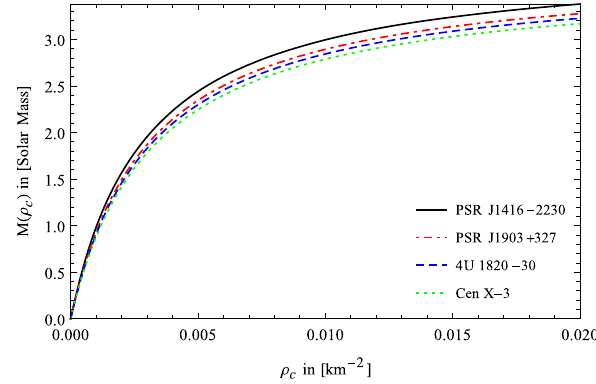
Fig. 8 Variation of total mass with central density for experimental statistics of four different compact stars. For plotting these graphs, the numerical values for the constant parameters are α = 0 . 030390 / km 2 , β = 0 . 000075 / km 4 , C = 0 . 9985 and D = 0 .